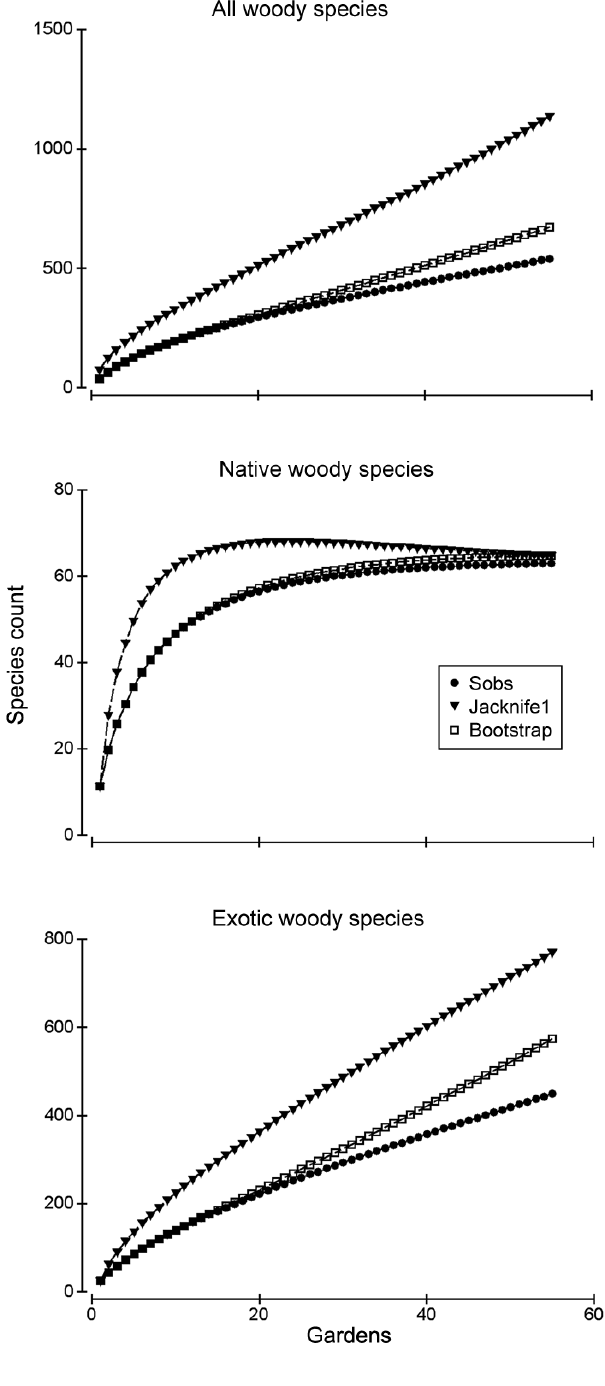
Table 1 . Mean and median number of species and individual woody plants in each garden, diversity (the reciprocal of the Simpson’s index), the total area/garden covered by beds, hedges and lawns, and the density of woody plants/ha.